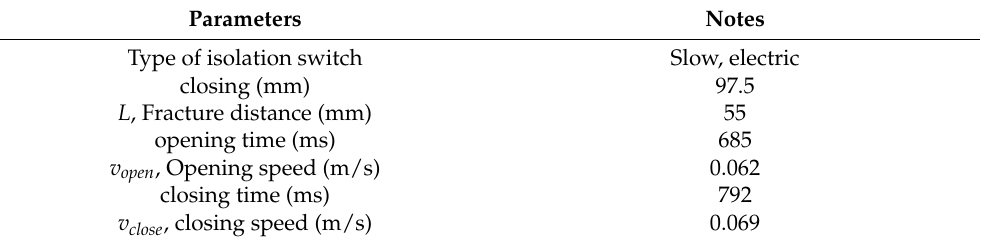
Figure 3. Simulation flow chart of VFTC. Table 3. Technical parameters of the 110 kV gas-insulated switchgear (GIS)